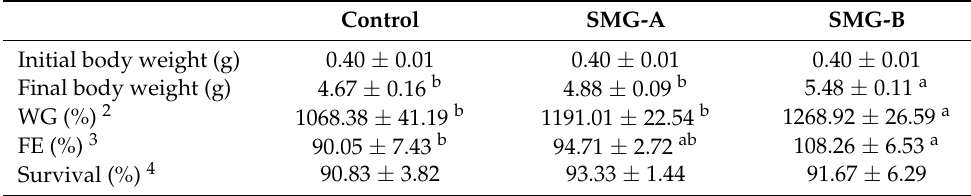
Table 1. Growth performance of the Pacific white shrimp in the control, SMG-A, and SMG-B groups throughout the 6-week culture period 1